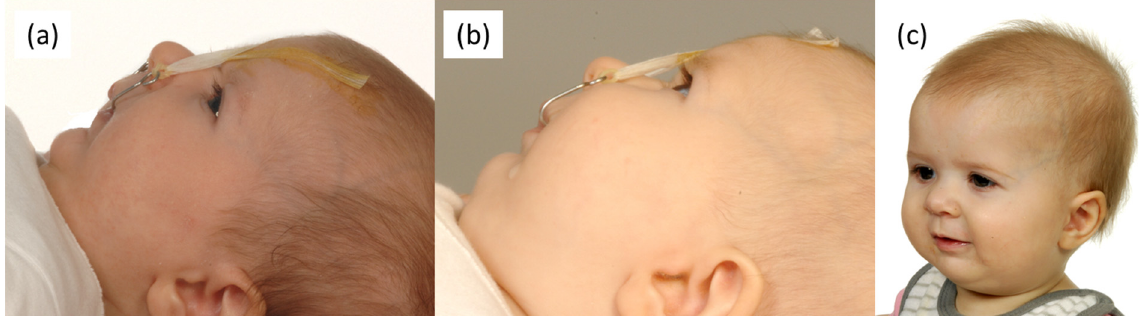
Figure 2. Mandibular growth development of a patient with Robin sequence treated with the Tübingen palatal plate (TPP) directly after birth: ( a ) facial profile after two months of TPP treatment; ( b ) facial profile after four months of TPP treatment; ( c ) patient after successful TPP treatment with eight months.